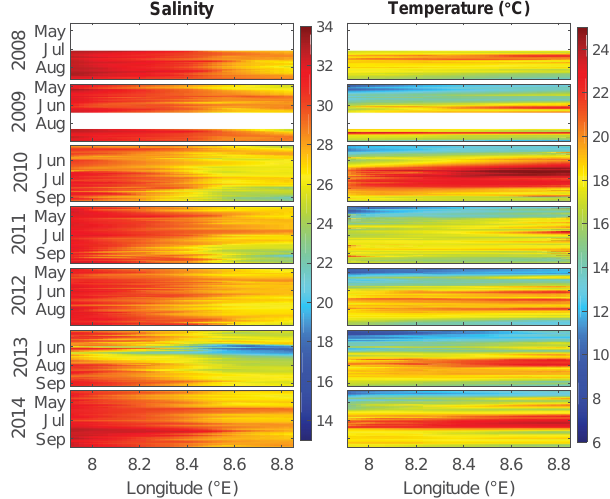
Figure 8. Salinity (left) and temperature (right) between Büsum and Helgoland for each summer between 2008 and 2014, collected by the M/V Funny Girl FerryBox. The ferry transect is shown in Fig.